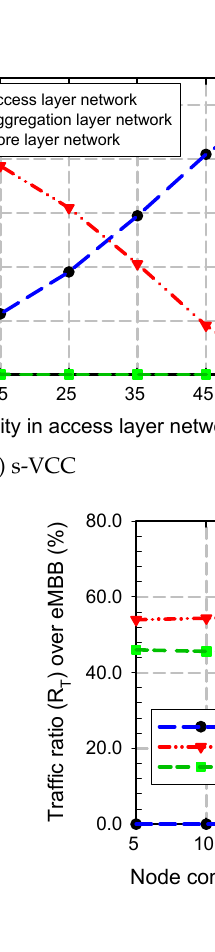
Figure 8. Transport network traffic distribution over s-VCC, eRTC and eMBB vs node connectivity in access layer